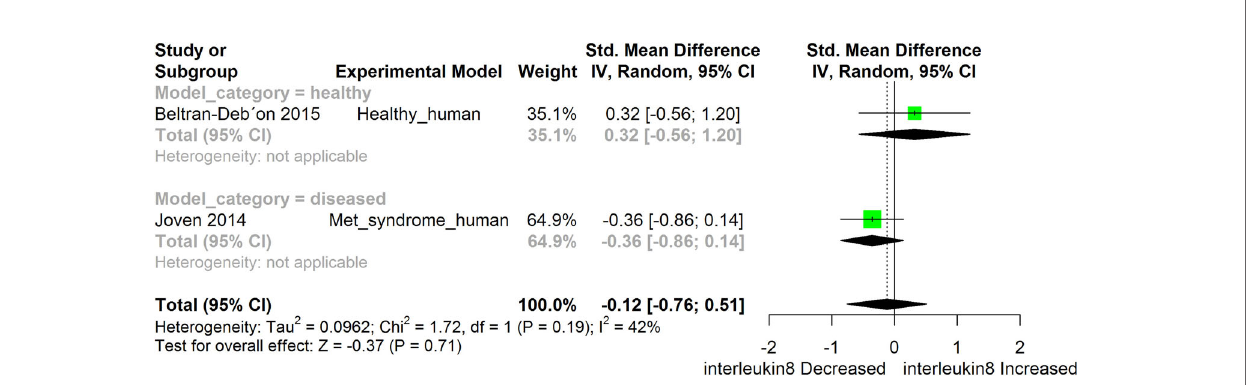
FIGURE 7 | Meta-analysis and forest plot of the effect of HS administration on IL- 8. The meta-analysis was sub-grouped by health status (i.e diseased or healthy state). The standardized mean difference (SMD), which is an estimate of the effect size, is presented as a square on the forest plot, for each study and as a diamond for the pooled estimate of each subgroup or overall studies. The overall pooled SMD for all included studies is shown in the bottom section of the forest plot. SMD data points that are lower than zero signify that treatments with HS lowered the level of the biomarker while those greater than zero signify that HS treatment causes an increase in the levels of the biomarker. The statistical signi fi cance of the pooled estimate is indicated by the Z test of signi fi cance. Met, Metabolic.